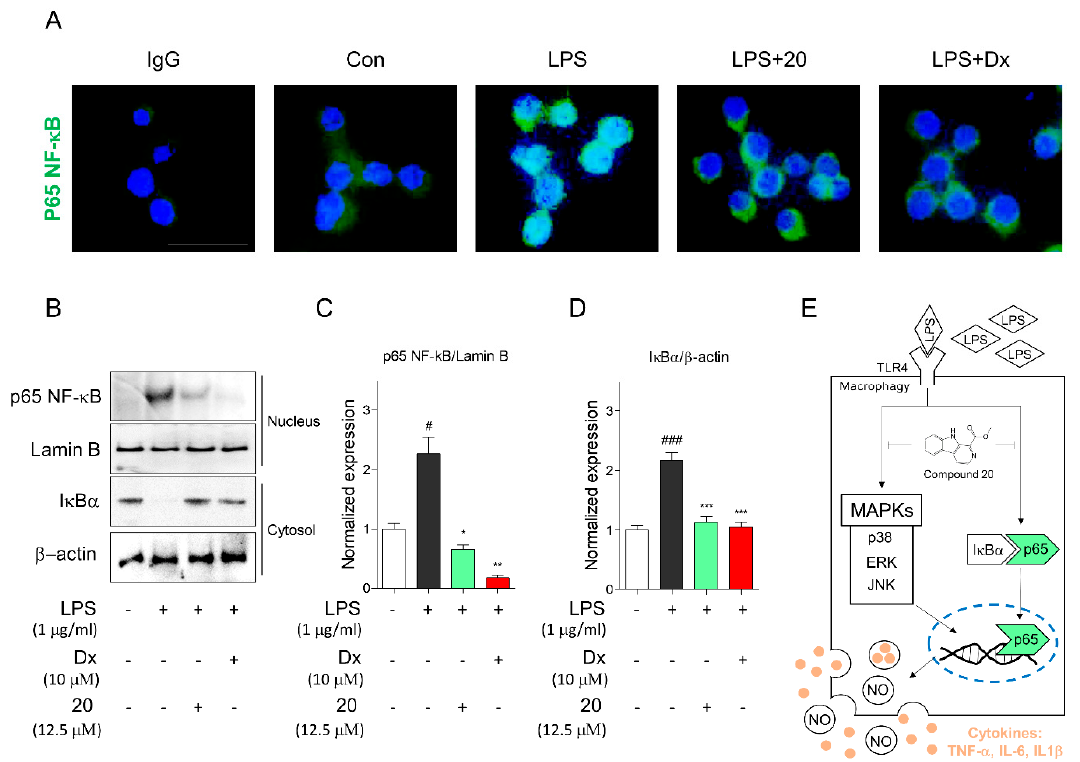
Figure 6. Compound 20 suppressed activation of NF- κ B. ( A ) Compound 20 suppressed nuclear translocation of NF- κ B. After 2 h of compound 20 treatment, the cells were fixed and permeabilized. NF- κ B (green) was immunostained with rabbit-anti-NF- κ B followed by FITC-conjugated secondary antibodies and the nuclei (blue) were stained with DAPI. The results shown are representative of two independent experiments. ( B ) Immunoblot analysis displayed that translocation of NF- κ B into nucleus and degradation of cytosolic I κ B α were suppressed by compound 20 in RAW 264.7 cells. ( C ) The graph is described as relative ratio of NF- κ B to lamin B. ( D ) The graph shows the relative ratio of I κ B α to β -actin using densitometry of ImageJ. ( E ) The schematic pathway of compound 20 is exhibited. Cells were pretreated for 2 h with compound 20 at concentration of 12.5 µ M, and stimulated with LPS (1 µ g / mL) for 1 h. Dexamethasone was used as positive control, and immunoblot analysis was performed as triplicate experiments. Values are means ± SEM, and an unpaired Student’s t- test was used for statistical analysis. # p < 0.05, and ### p < 0.001 versus Con, * p < 0.05, ** p < 0.01, and *** p < 0.001 represented significant di ff erences from the LPS-treated group. Con: control, LPS: lipopolysaccharide, Dx: dexamethasone.